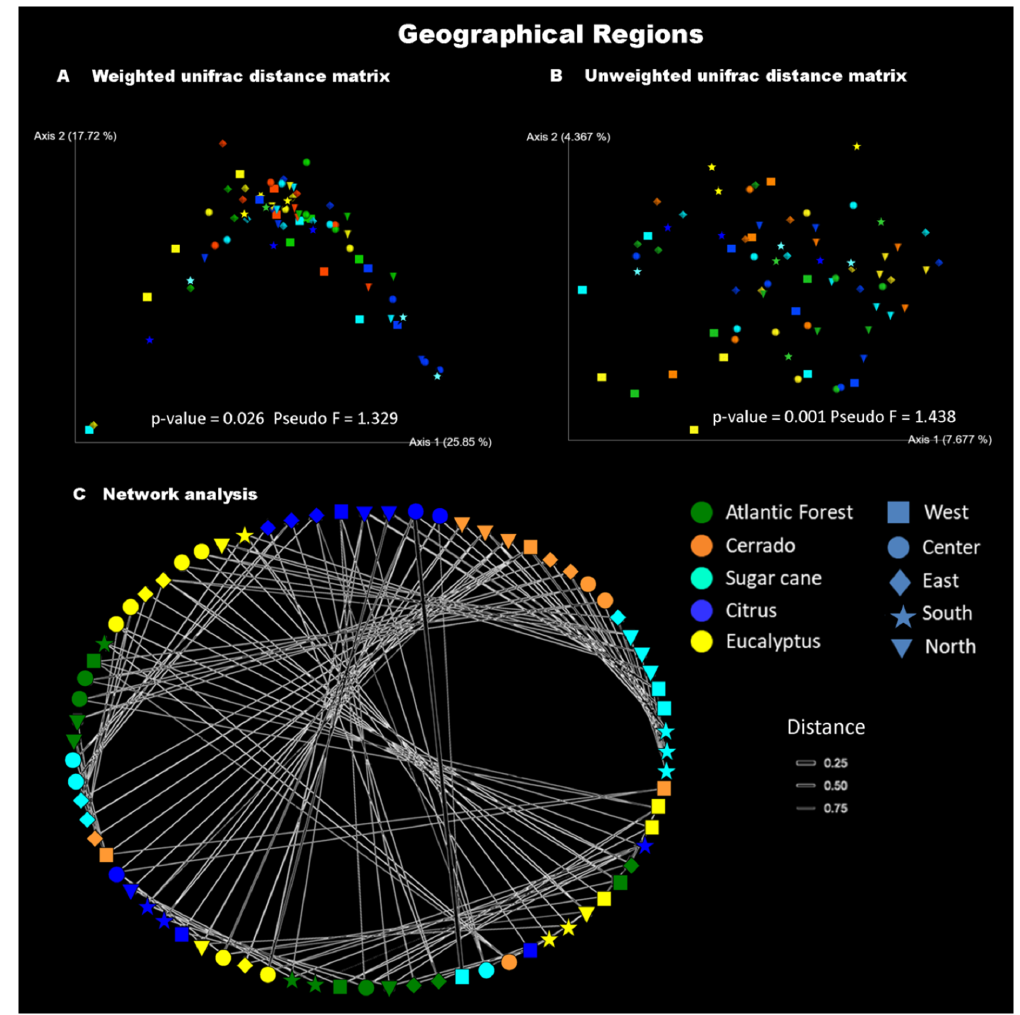
Figure 6. Plot illustrating bacterial community structure among Atta sexdens workers of different regions (West, Center, East, South, and North), and habitats (natural and agricultural). ( A ). Principal coordinates analysis (PCoA) with weighted unifrac distance matrix. ( B ). PCoA with unweighted unifrac distance matrix. ( C ). Network analyses of bacteria present in Atta sexdens workers in different habitats. Note the complexity of the bacterial communities associated with leaf-cutting ants. Colors represent different habitats, and shapes represent different geographical regions.